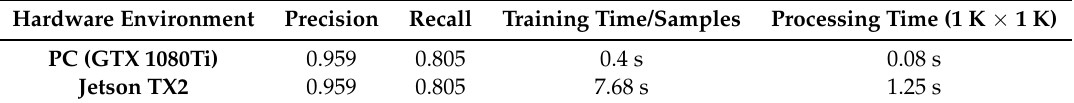
Table 4. Comparisons of different hardware